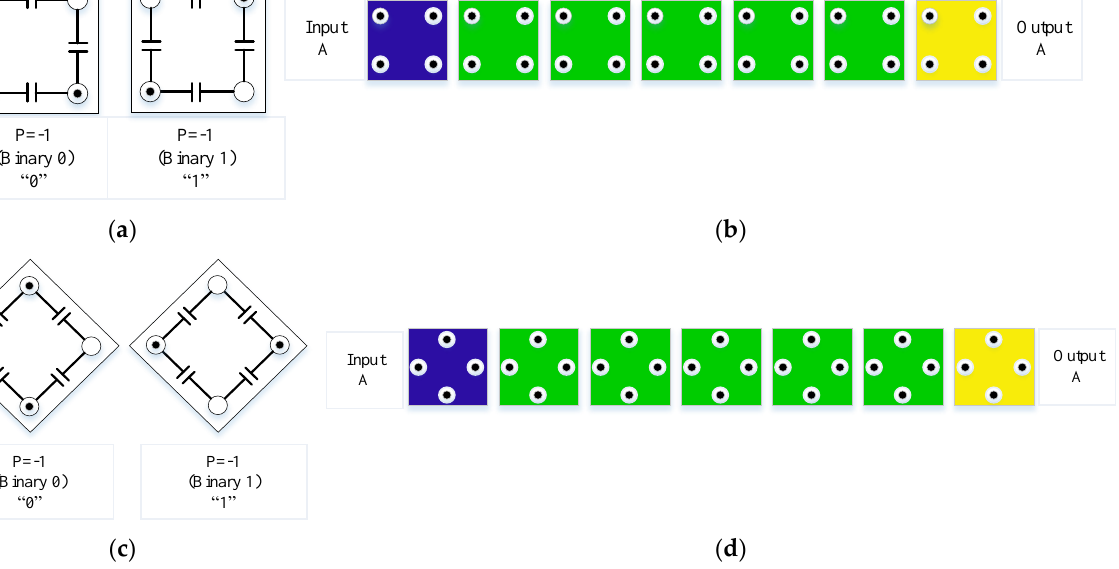
Figure 1. ( a ) Normal QCA cells ’ structure, ( b ) Normal QCA wire ’s structure, ( c ) Rotated QCA cells ’ structure and ( d ) Rotated QCA wire ’s structure.